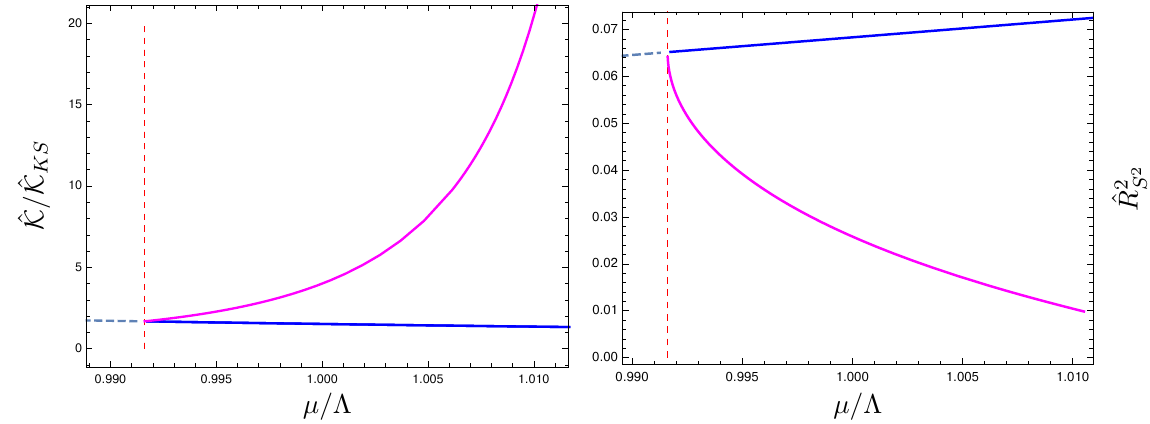
b s of vacua (magenta curve) and A A K V V denotes the value of K KS b vacua) when µ & µ u (denoted by the vertical dashed red A V